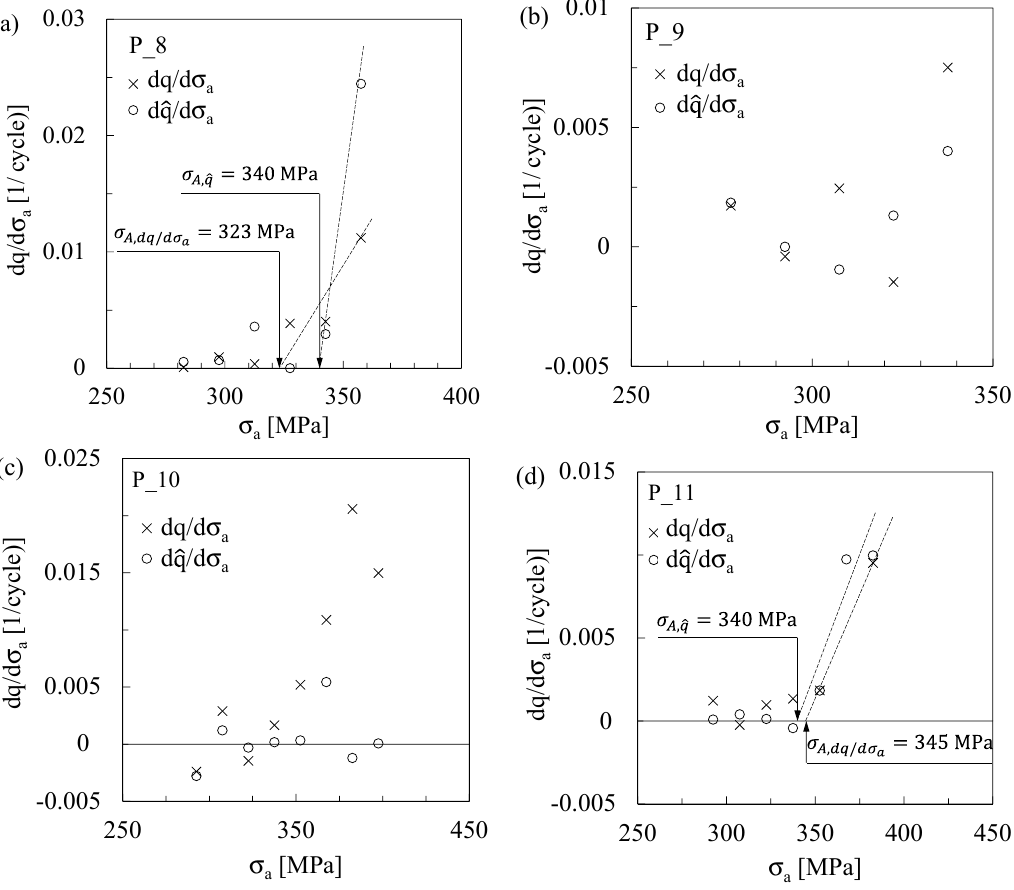
Figure 21. Step load-fatigue tests reanalyzed in terms of the rate of the ˆ q parameter according to the “phase lock-in method” and in terms of the rate of the q parameter, according to the “conventional lock-in method”, for ( a ) P_8, ( b ) P_9, ( c ) P_10, and ( d ) P_11 specimens.